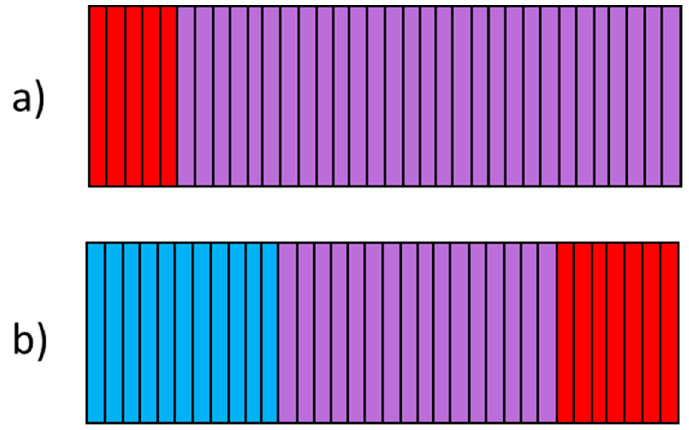
Figure 7. Two hypothetical 29-mod designs with reactor modules (red), membrane modules (blue), and membrane reactor modules (purple). Here, ( a ) is a 29-mod design that is very similar to the 30-mod design in Figure 6, whereas ( b ) represents a very different 29-mod design.